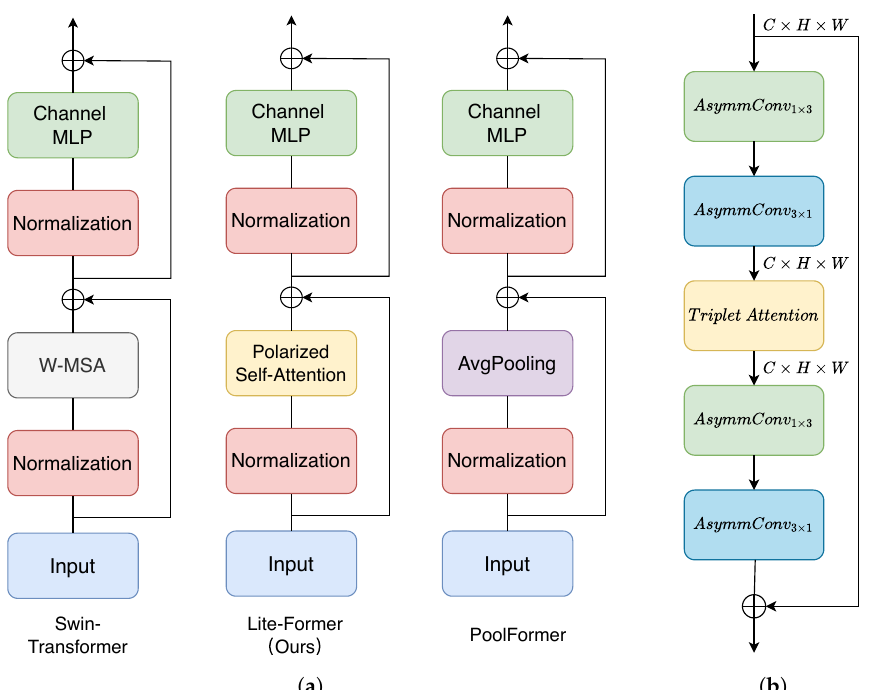
Figure 4. Illusion of the basic block. ( a ) The left most one illustrates the block structure of the Swin Transformer, the middle one is that of ours, and the right most one is that of PoolFormer. ( b ) Demonstration of the attention-refined